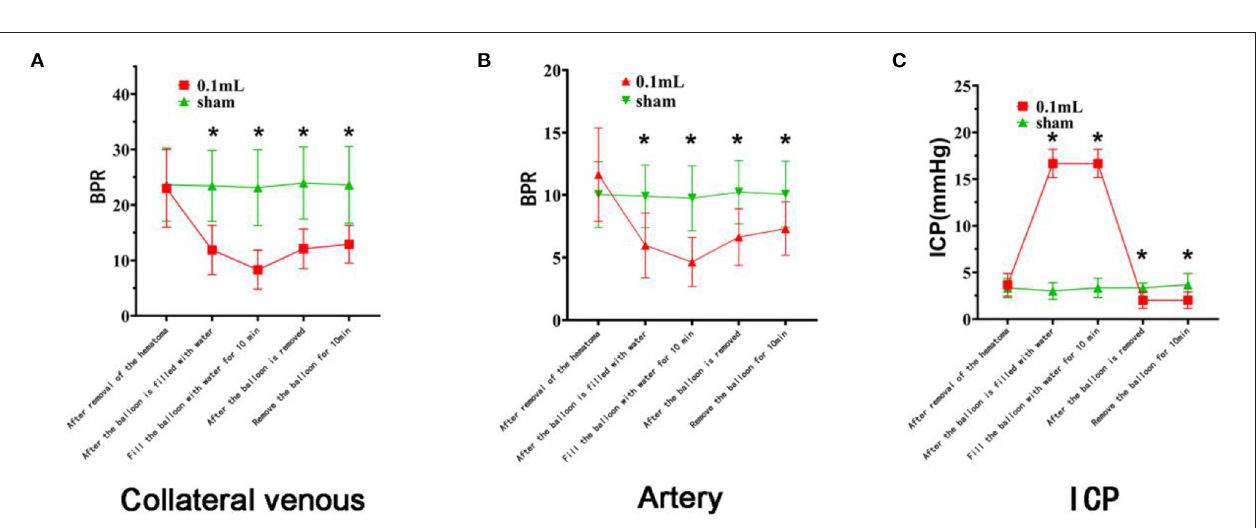
FIGURE 6 | Changes in cerebral surface dynamics, venous blood flow, and intracranial pressure on the side with the brain bulge. The red curve represents the 0.1ml group, and the green curve represents the Sham group. (A) There was no difference in BPR (mean ± standard deviation) between the two groups after the removal of the lateral vein hematoma. After the balloon was filled with water and the brain tissue was expanded, the BPR of the experimental groups decreased significantly (asterisk). After the balloon was removed, the BPR gradually recovered but did not return to the initial state. (B) There was no difference in BPR (mean ± standard deviation) between the two groups after the removal of the arterial hematomas. After the balloon was filled with water and the brain tissue expanded, the BPR in the two groups decreased significantly (asterisk). After the balloon was removed, the BPR gradually recovered but did not return to the initial state. (C) There was no difference in intracranial pressure between the two groups after hematoma removal, although there were significant differences at the time points after balloon filling and after balloon removal (asterisk).